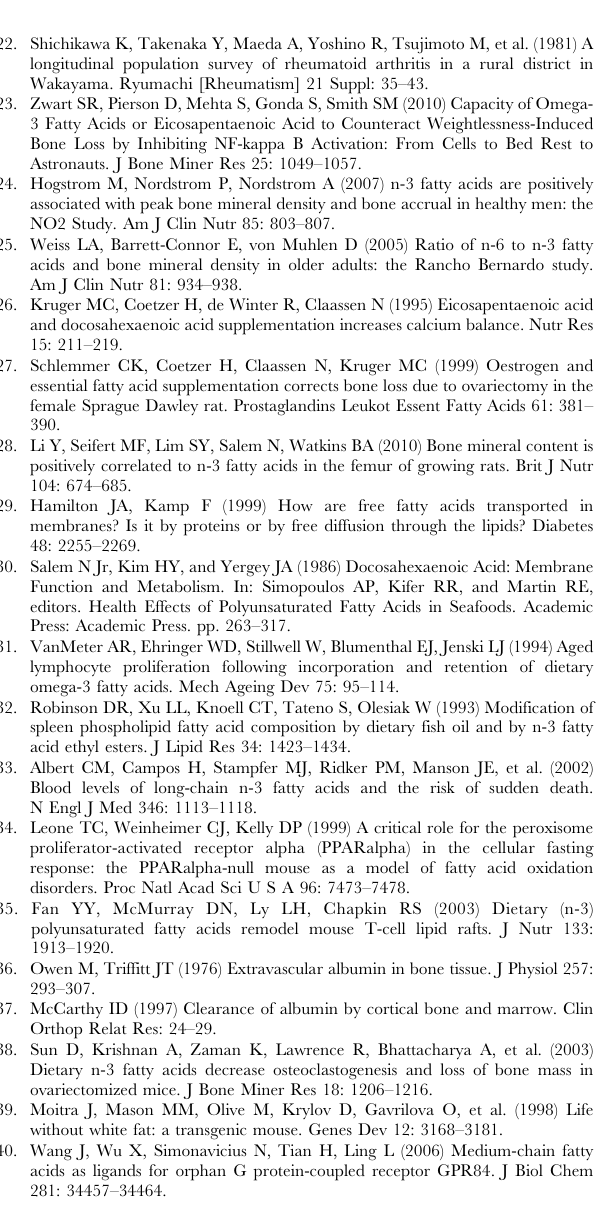
Figure S2 Fluorescence anisotropy of PTH1R